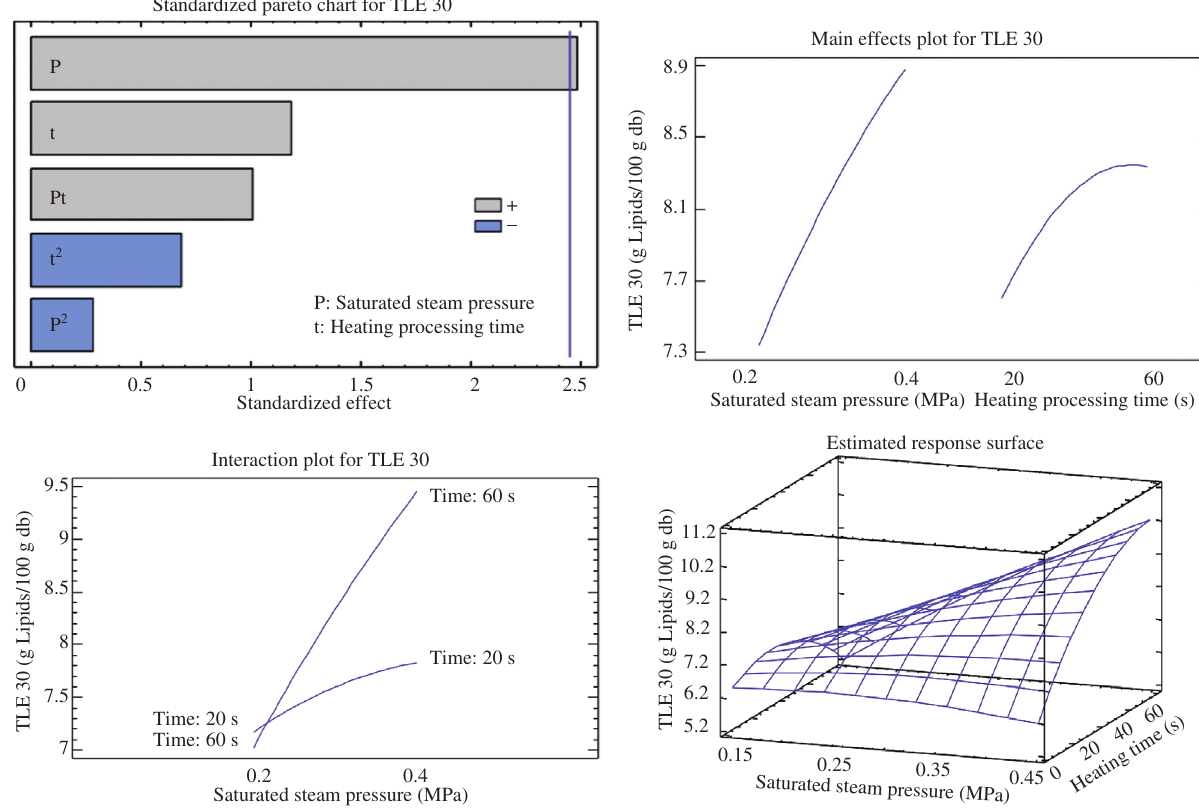
Figure 3 Pareto chart, general trends, cross effects and response surface of instant controlled pressure drop (DIC) operating parameters for total lipids extracted (TLE) after DIC treatment of microalgae (initially at water content of 30%